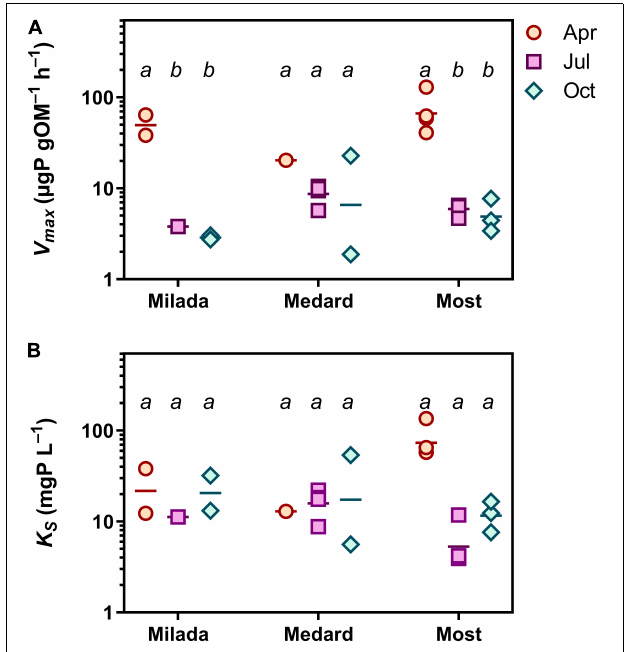
FIGURE 3 | Epilithon P uptake in three post-mining lakes sampled in the Czech Republic in 2019. (A) Maximum P uptake capacity, V max . (B) Half-saturation constant, K S . Symbols in two lower panels show individual values. Different lowercase letters indicate significant seasonal differences within lakes ( p < 0.05, two-way ANOVA and Tukey’s multiple comparisons post-test).